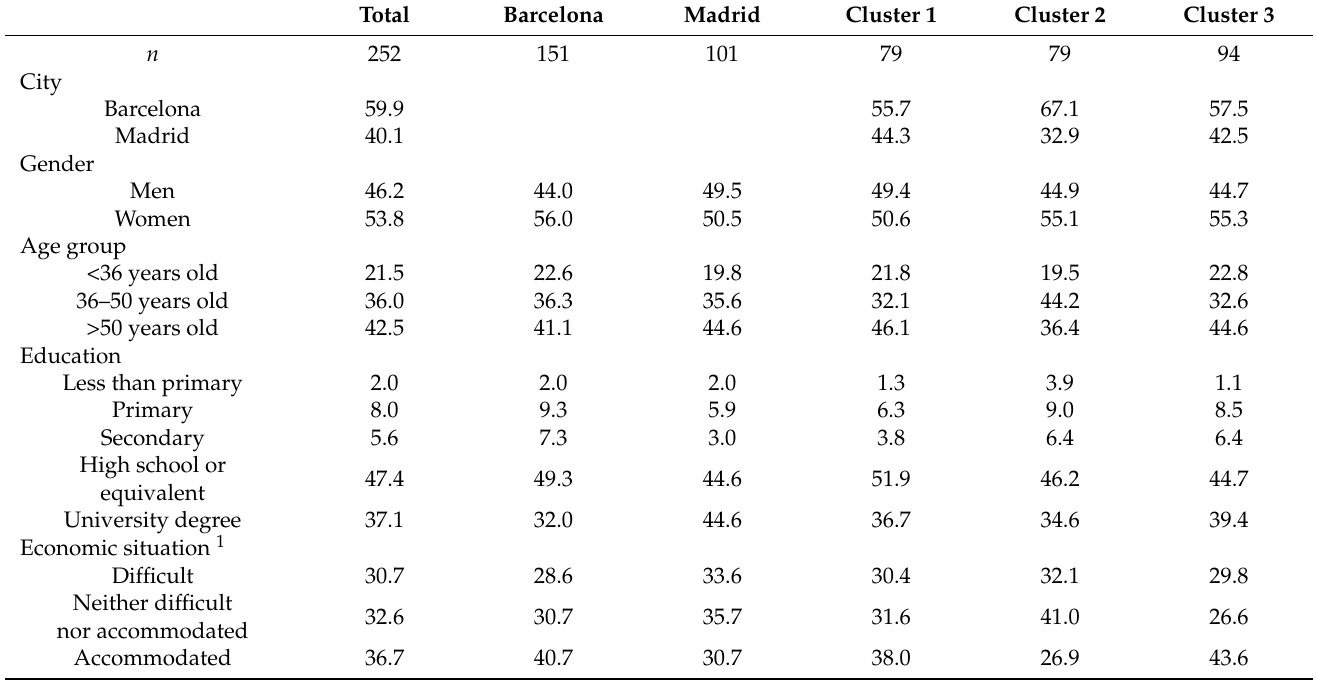
Table 1. Demographic characteristics of the consumers by city and cluster